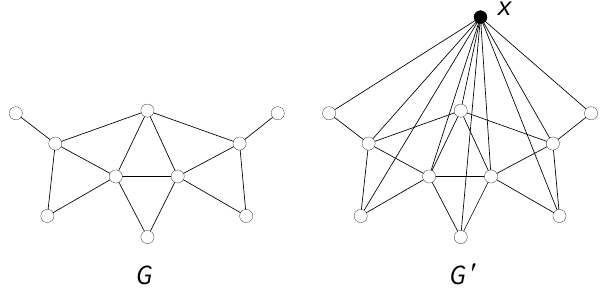
Figure 1. The graphs G and G (cid:48)